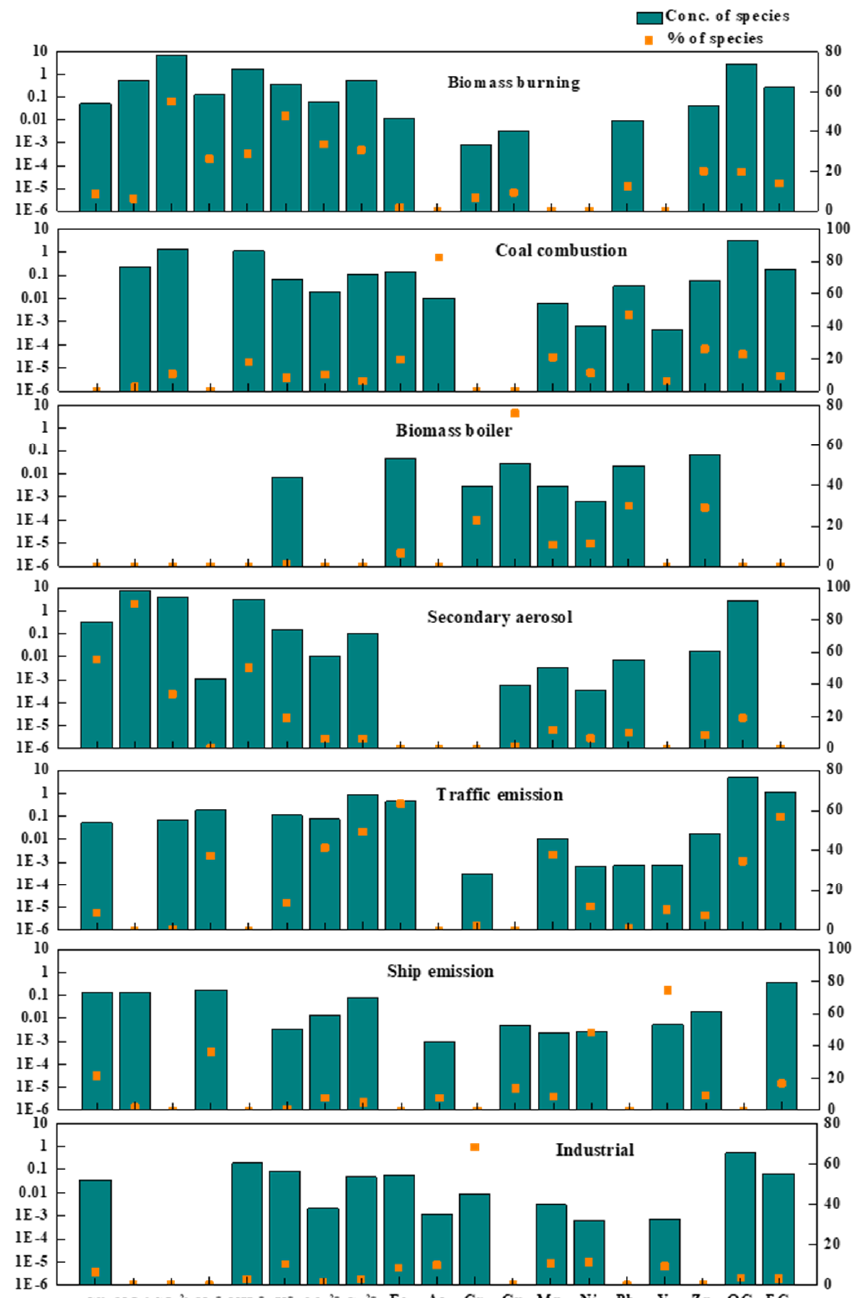
Figure 2. Source profiles of seven sources identified by the PMF model (concentration units: μg/m 3 ).